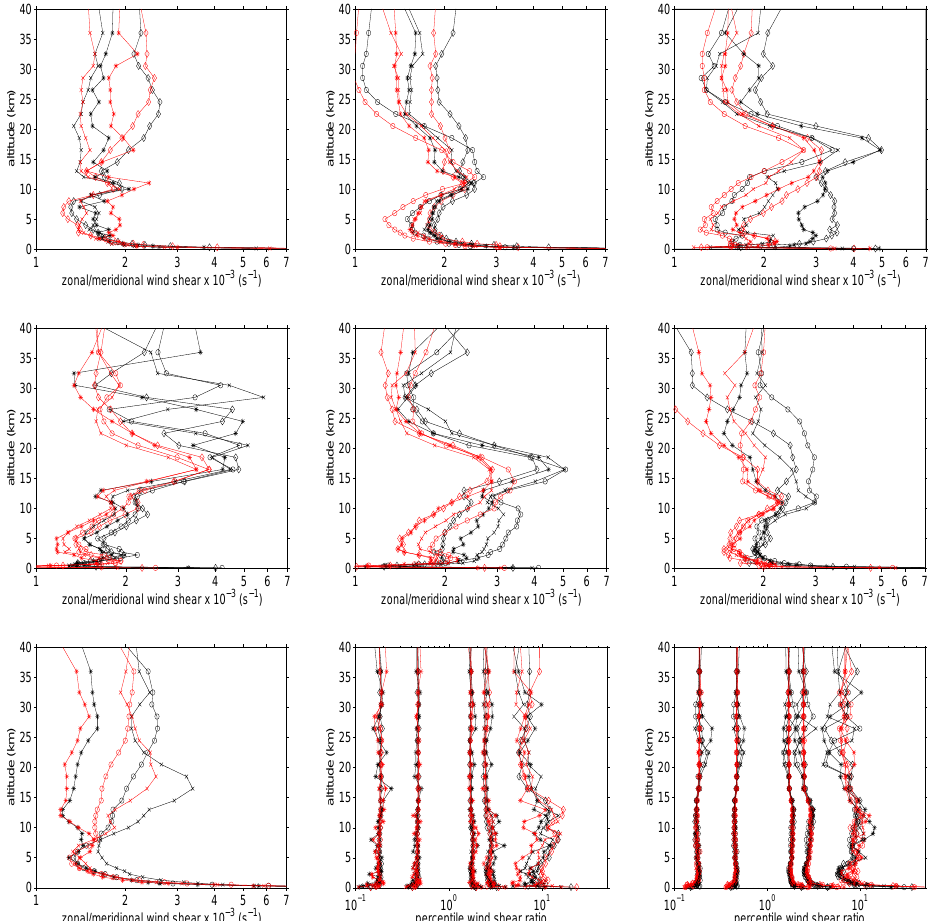
Fig. 10. Same as Fig. 9 but now for the median zonal (black) and meridional (red) absolute wind-shear (s − 1 ). The x -axis has a logarithmic scale. The middle (NH polar region) and right (tropics) panel in the bottom row show the ratio of percentile profiles and the median profile for (from left to right) the 10%, 25%, 75%, 90% and 100% (absolute maximum) percentile